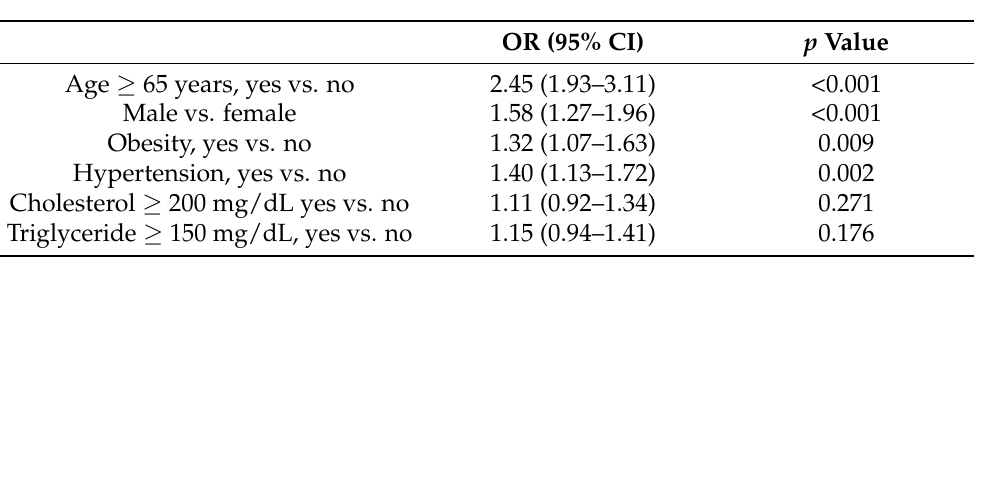
Table 2. Binomial logistic regression for the relationship between clinical variables and significant liver